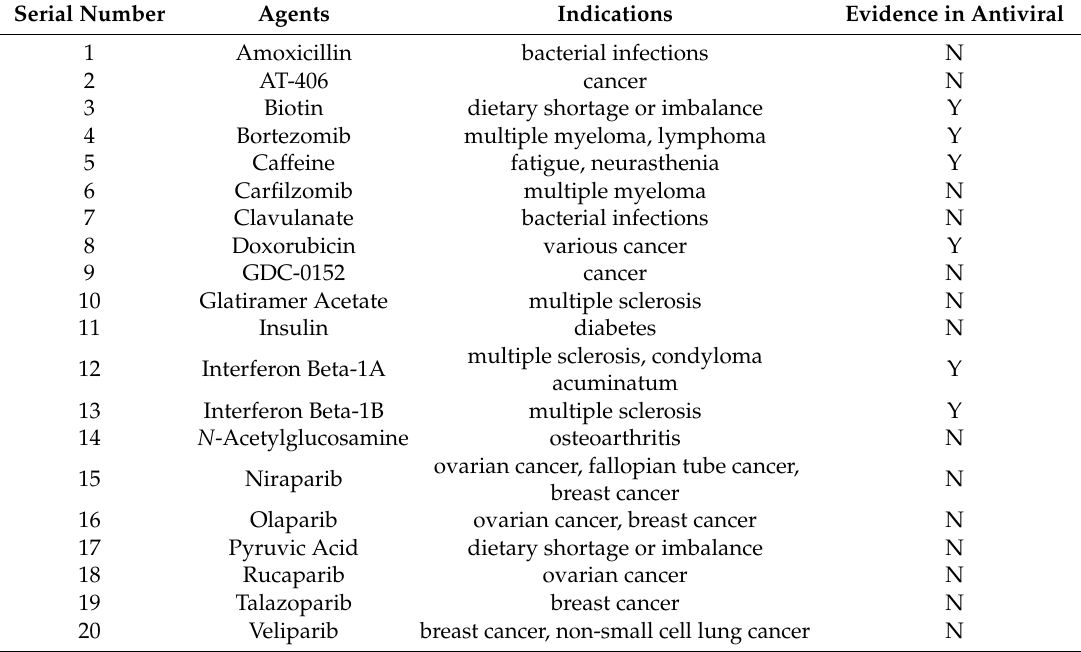
Table 2. Agents targeting the genes identified by the HotNet2